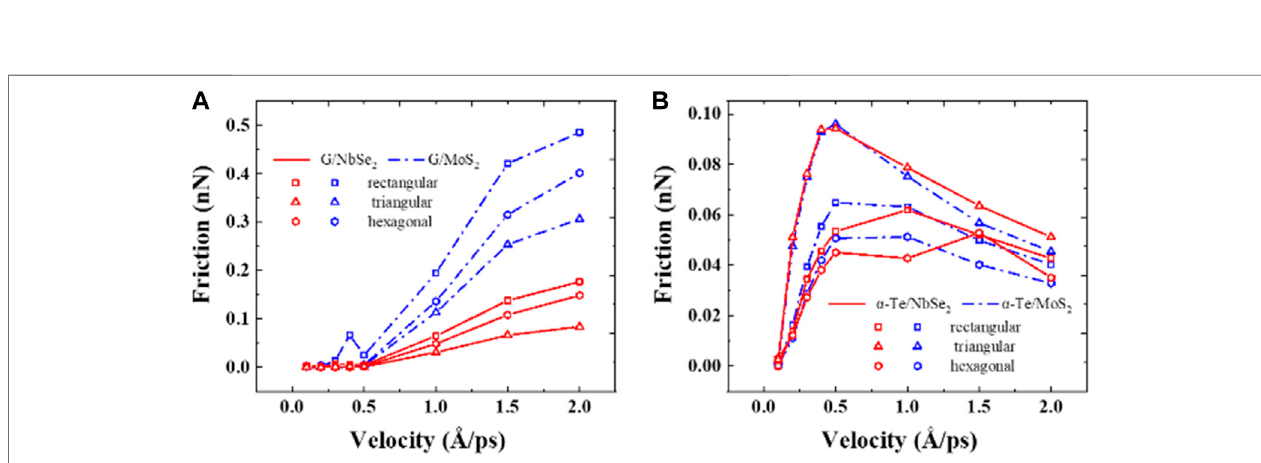
FIGURE 14 | Effect of sliding velocity on interlayer friction. The shape of the data points represents the shape of the slider in the simulation, which are rectangular, triangular, and hexagonal. (A) graphene/MoS 2 and graphene/NbSe 2 heterostructures; (B) α -Te/MoS 2 and α -Te/NbSe 2 heterostructures.